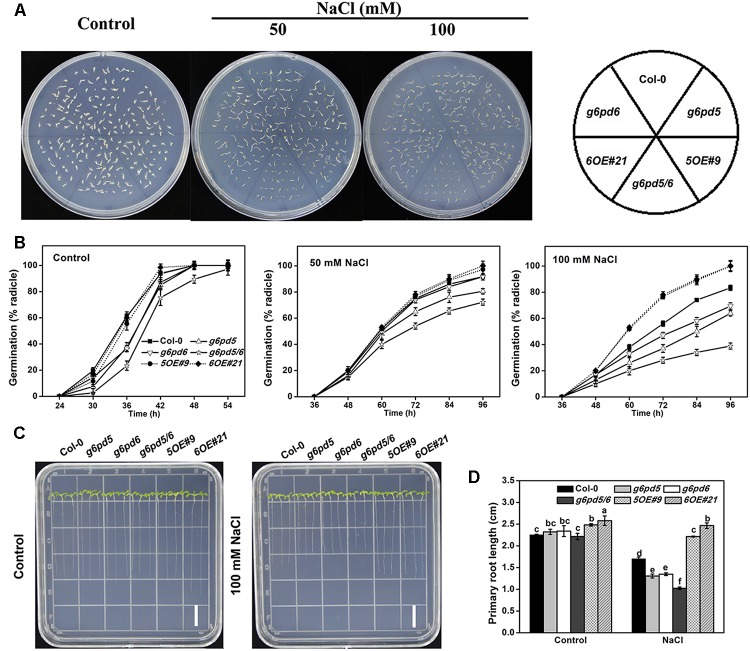
Seed germination and root growth of WT, g6pd5 mutant, g6pd6 mutant, g6pd5/6 mutant, G6PD5-OE, and G6PD6-OE
Arabidopsis in response to NaCl stress. Seeds were germinated on ½ MS agar plates with or without various concentrations of NaCl. (A) Photographs were taken 3 days in terms of radical emergence after NaCl treatment. (B) Percentage of seed germination in WT, g6pd5 mutant, g6pd6 mutant, g6pd5/6 mutant, G6PD5-OE, and G6PD6-OE with or without different NaCl treatment. (C,D) 5-day-old seedlings were grown vertically on ½ MS agar plates supplemented with the indicated concentrations of NaCl for 3 days. Root growth was monitored and analyzed using ImageJ software. Data are reported as the average value of three replicates using >50 seeds for each genotype. One-way Duncan’s test was performed, and statistically significant differences are indicated by different lower case letters (P < 0.05). Bar, 1 cm. The experiments were repeated at least three times with similar results, and data from one representative experiment are presented.